Question: Summarize what this figure shows in one sentence.
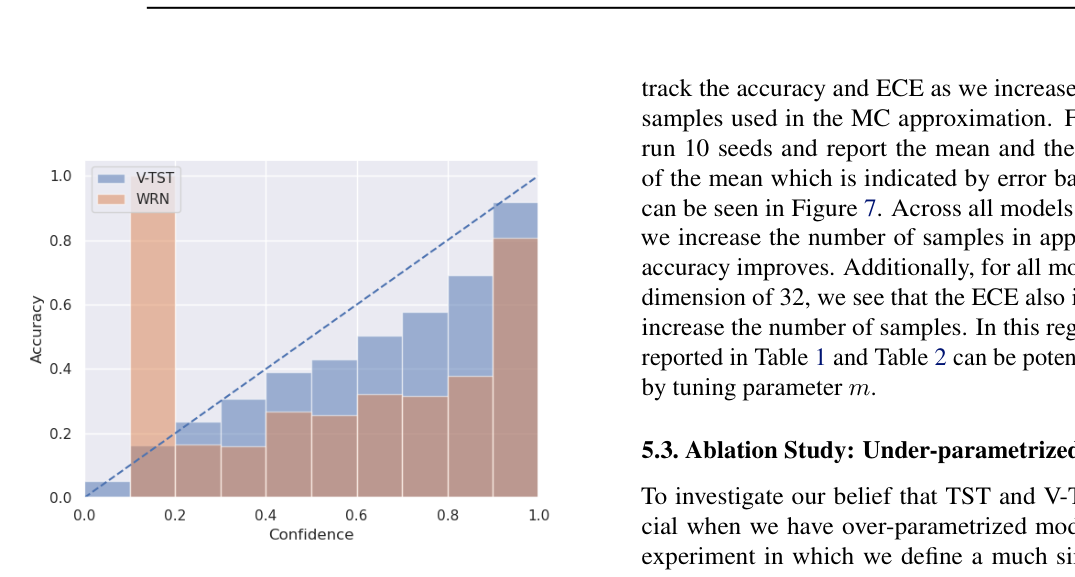
Answer: ECE plot of V-TST trained model and base WRN trained on CIFAR100.